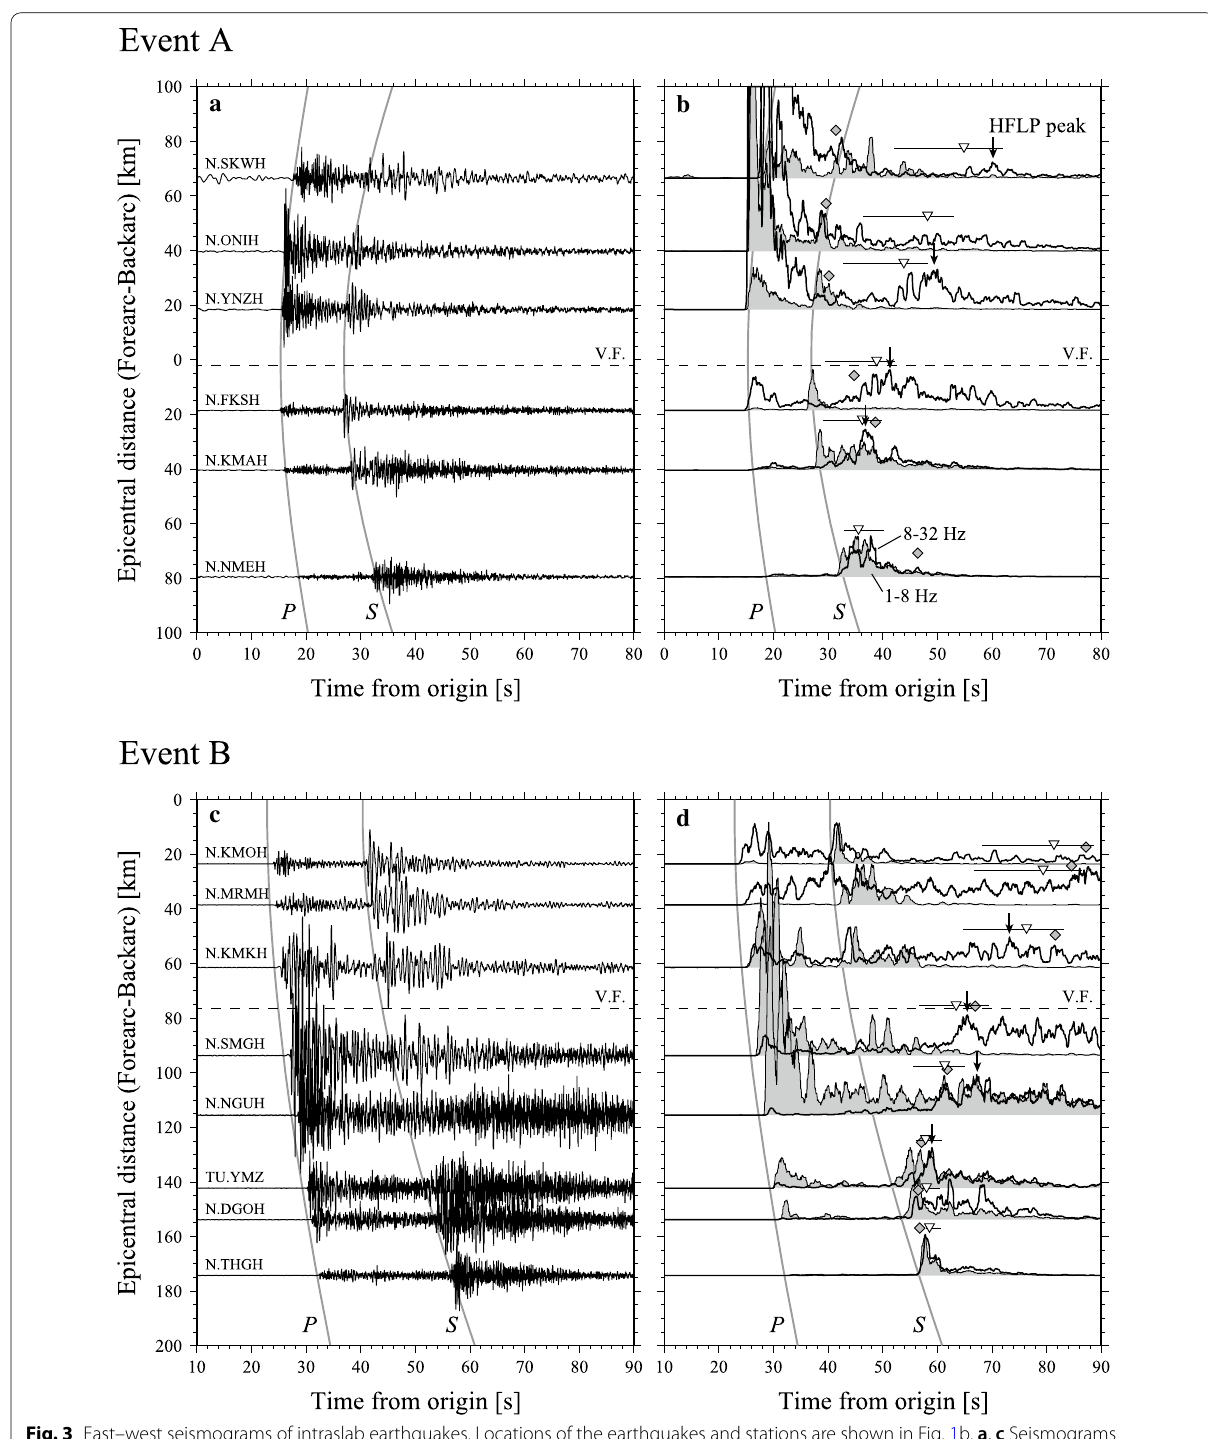
Fig. 3 East–west seismograms of intraslab earthquakes. Locations of the earthquakes and stations are shown in Fig. 1b. a , c Seismograms bandpass-filtered at 1–32 Hz, and b , d their MS envelopes in different frequency ranges: 1–8 Hz (filled gray lines) and 8–32 Hz (thick black lines). Arrows indicate the identified peak amplitudes of the HFLPs. White inverted triangles show the expected delay times of the waves scattered at the passing points (their temporal ranges correspond to the location uncertainties displayed in Fig. 5). Gray diamonds indicate the expected delay times at the passing points in Fig. 7. Gray curves denote the arrival times of the direct P and S waves expected for the JMA2001 one-dimensional velocity model (Ueno et al. 2002). Dashed lines represent the locations of the arc volcanic front